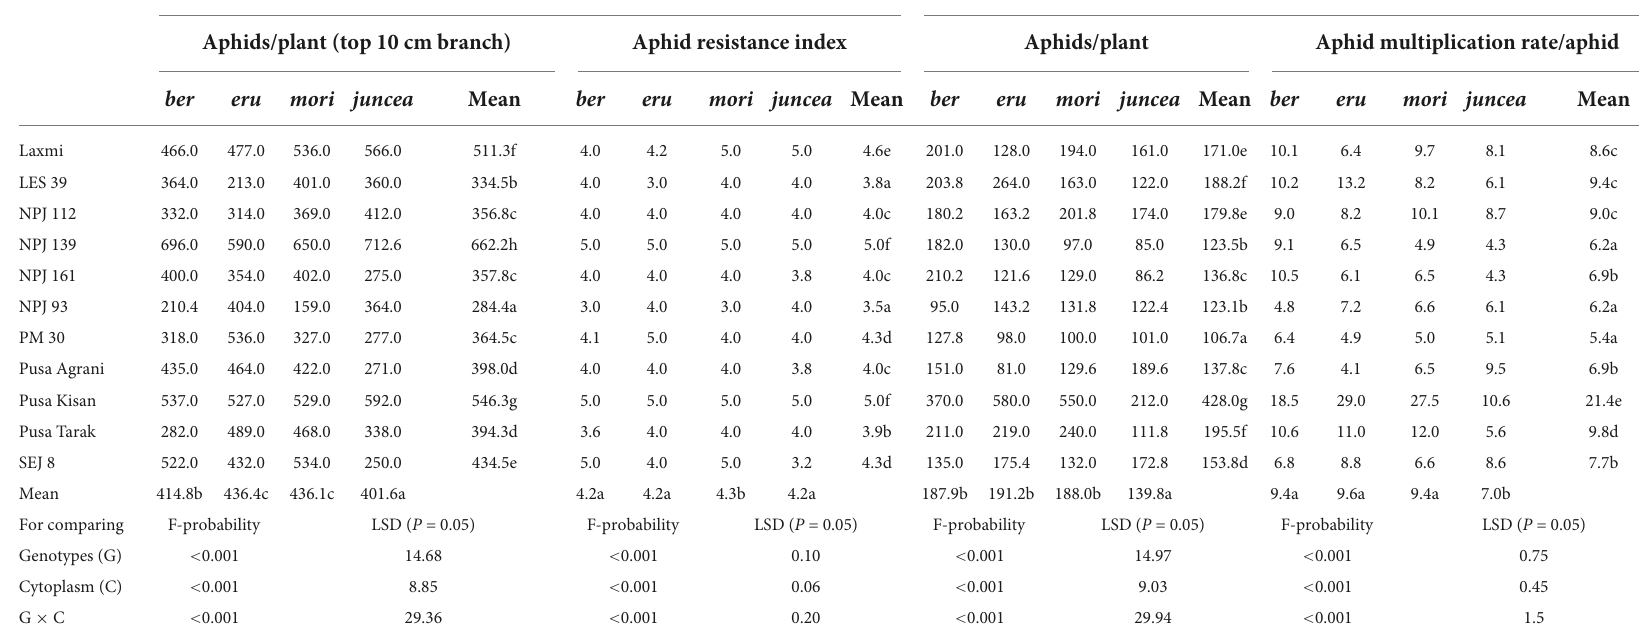
TABLE 1 Effects of cytoplasms and nuclear backgrounds on aphid resistance index, population build up and multiplication rate of Lipaphis erysimi in auto- and alloplasmic lines of Brassica juncea . Nuclear backgrounds ( B. juncea